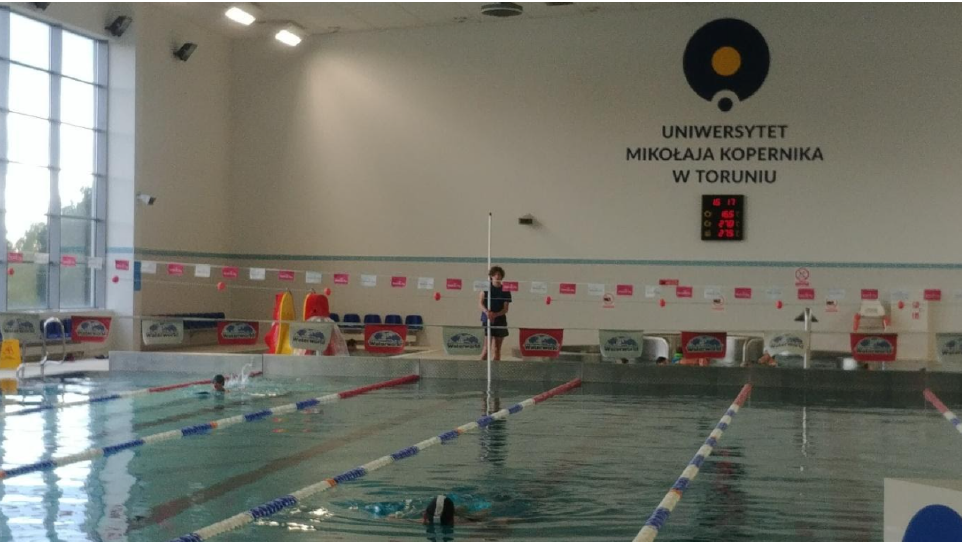
Figure 13. One of the authors (holding a stick with a submerged transmitter) during the system